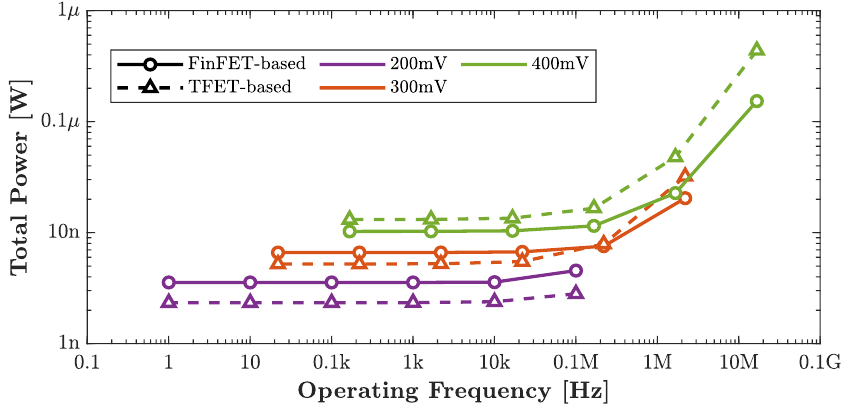
Figure 10. TFET- and FinFET-based MSP-430 total power consumption as a function of the operating frequency for the operating supply voltages of 200 mV, 300 mV, and 400